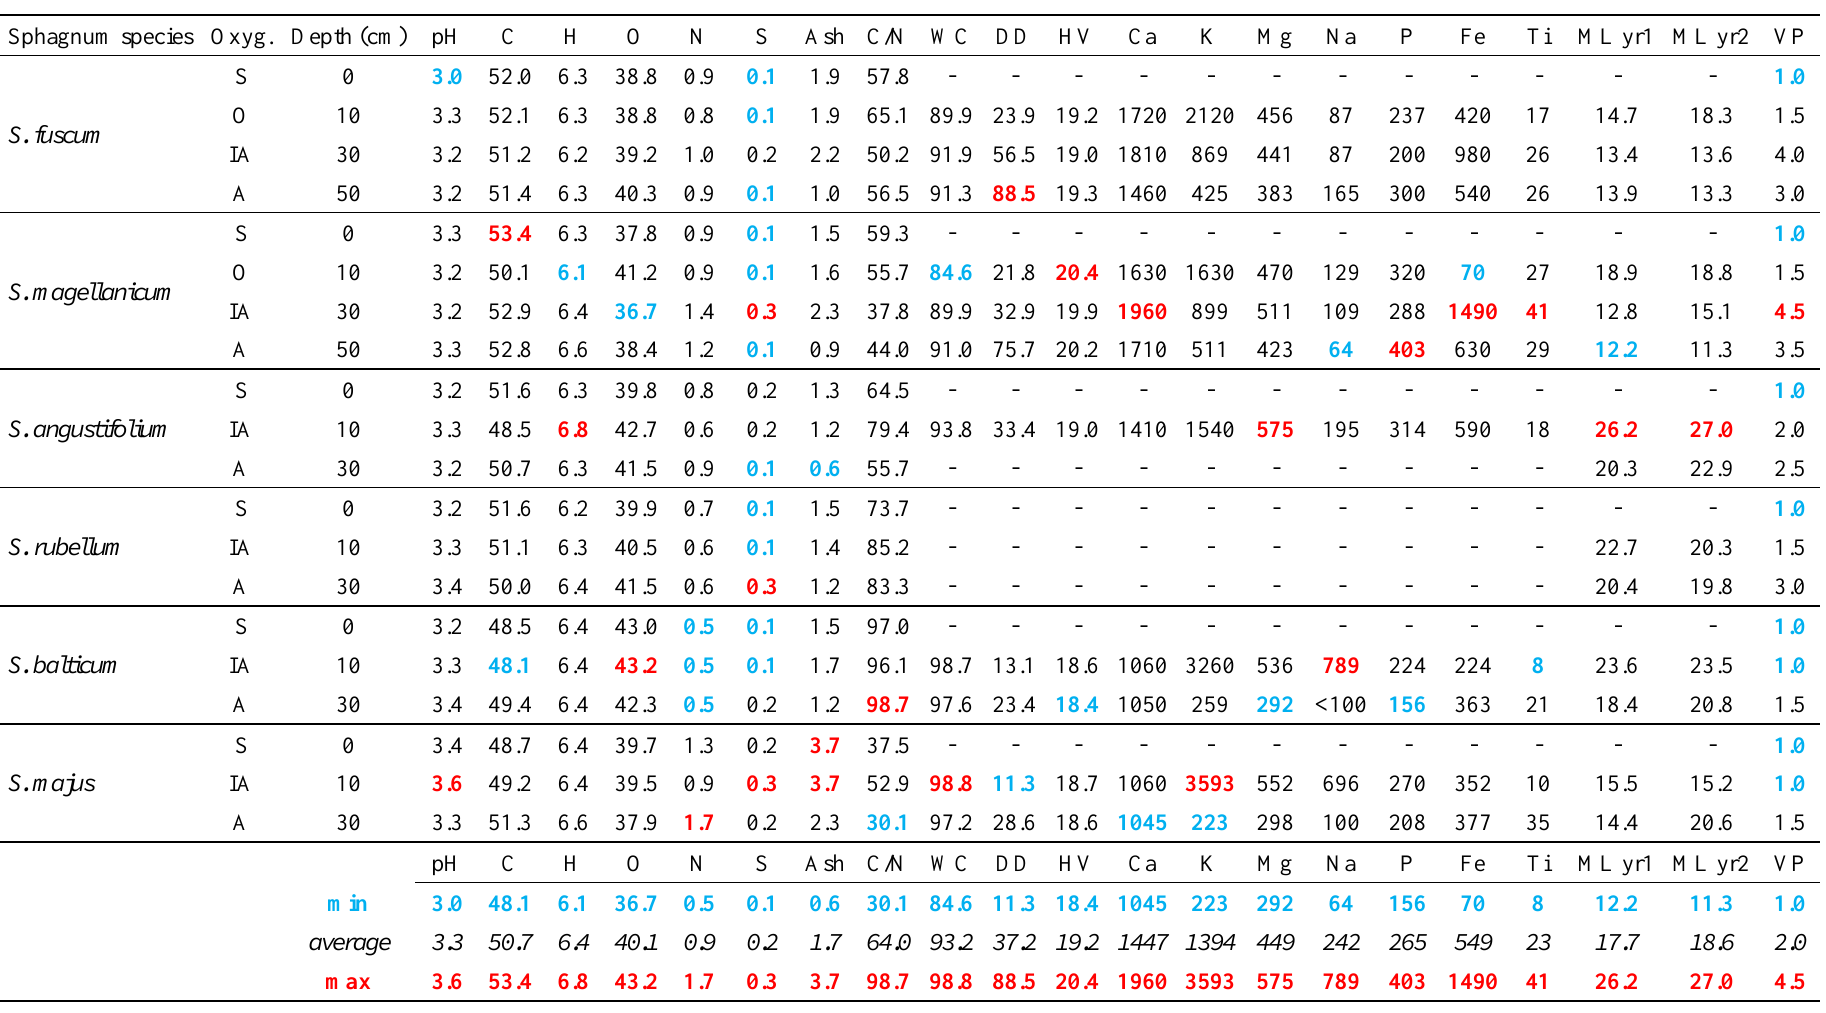
Table 3. Chemical and physical properties of different Sphagnum species in their native microhabitats. Samples were taken from the surface moss (S), from (depth) 5–15 cm oxic (O), 25–35 cm intermittently anoxic (IA) and 45–55 cm anoxic (A) layers. Units and abbreviations: Depth: cm; C, H, O, N, S, ash: % of dry mass; WC (water content): % of wet mass; DD (dry density in situ ): kg m -3 ; HV (heating/calorific value): MJ kg -1 ; Ca, K, Mg, Na, P, Fe and Ti: mg kg -1 ; ML yr1 (mass loss after one year): %; ML yr2 (mass loss after two years): %, VP: H (1–10) on the von Post scale. Missing data were not collected. Sphagnum species Oxyg. Depth (cm)